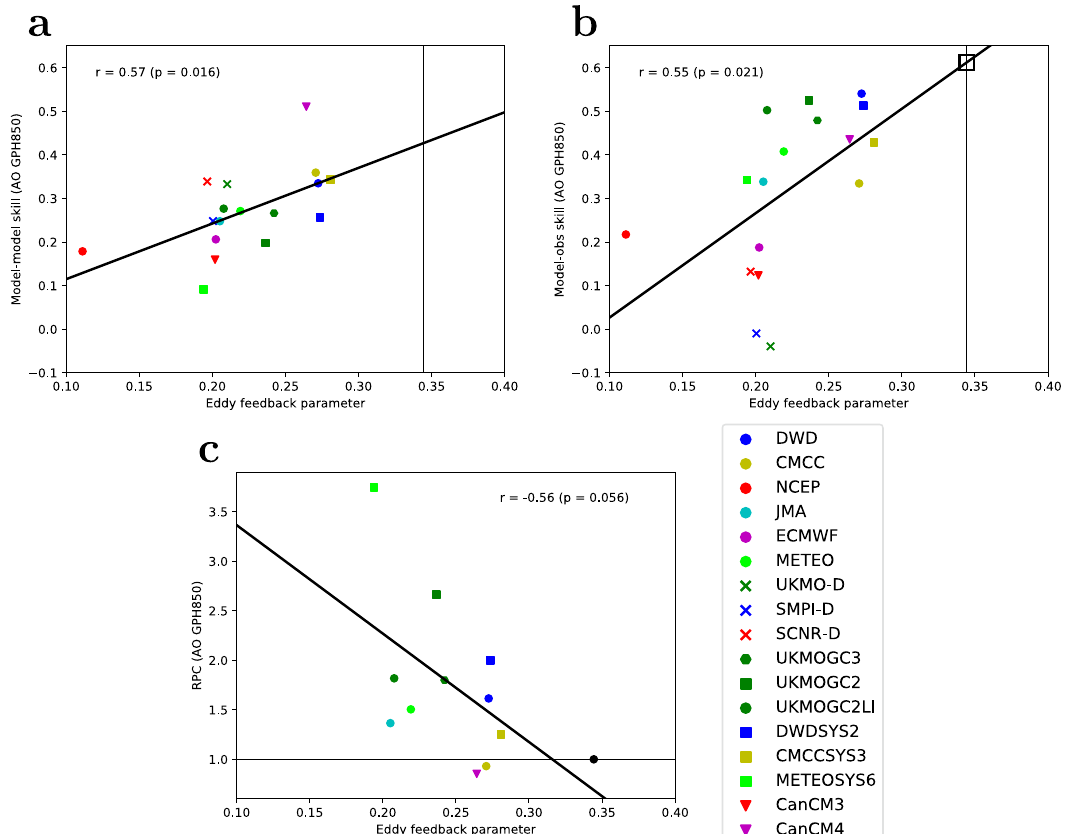
Fig. 1 Eddy feedback relation to skill and RPC. Eddy feedback parameter (EFP) correlated with model – model skill ( r mm ), model – observed skill ( r mo ) and RPC (the ratio of predictable components, where RPC = r mo / r mm ), as calculated from the AO index using geopotential height at 850 hPa (AO GPH850). EFP is de fi ned as the correlation squared between the December – January – February horizontal EP- fl ux divergence and the zonal mean zonal wind, at each latitude at 500 hPa, area weighted 25 ∘ N – 72 ∘ N. The value of EFP computed from ERA5 reanalysis data is shown with a black vertical line in a and b and as a black circle in c . Thick black lines show linear least squares regression lines. In b the point where the regression line crosses the observed value of EFP is marked with a hollow black box as discussed in relation to Fig. 4. Models used in c are those that have signi fi cance at the 90% level in b , equating to an r mo value greater than 0.277. In Table 1, the same subset of models is used at all levels. See ‘ Methods ’ section for explanation of different